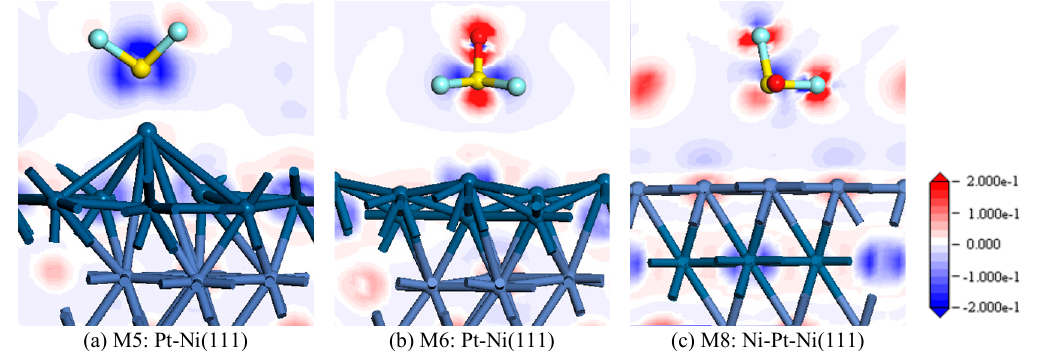
Figure 7. Electron density difference of SOF 2 adsorption on ( a ) M5:Pt-Ni(111), ( b ) M6:Pt-Ni(111), and ( c ) M8:Ni-Pt-Ni(111) surfaces.